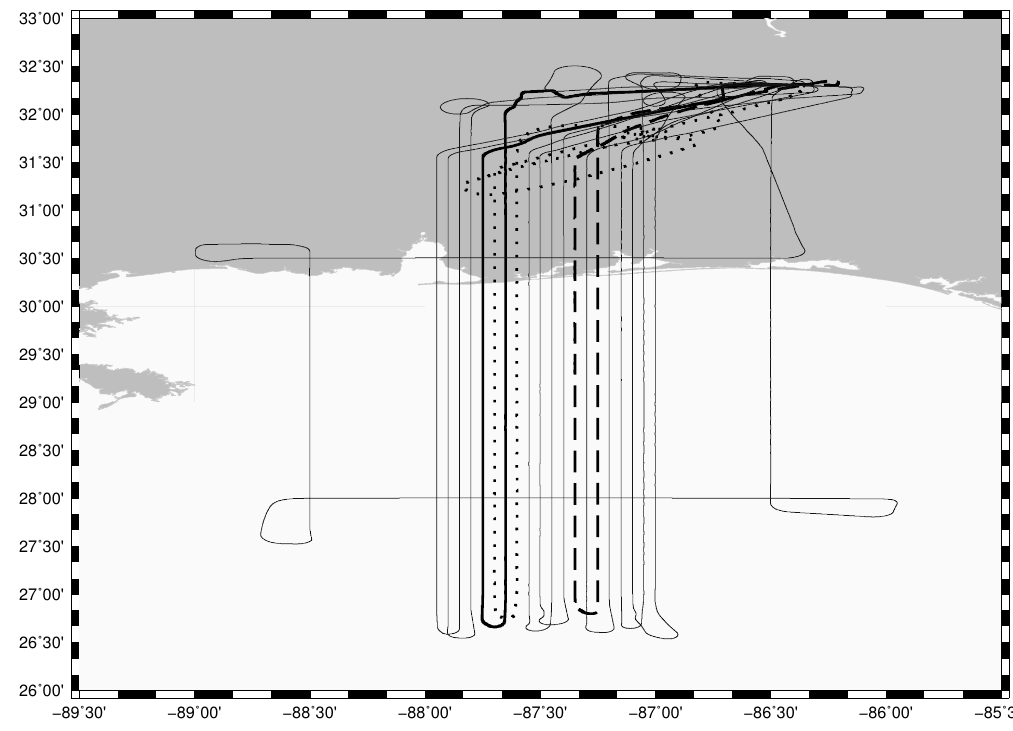
Figure 1. The Alabama aerogravity campaign conducted by NGS (Thicker lines, dotted lines, and dashed lines represent the trajectories of Flight A at 11 km high, Flight B at 6km high, and Flight C at 1.7 km high, respectively).